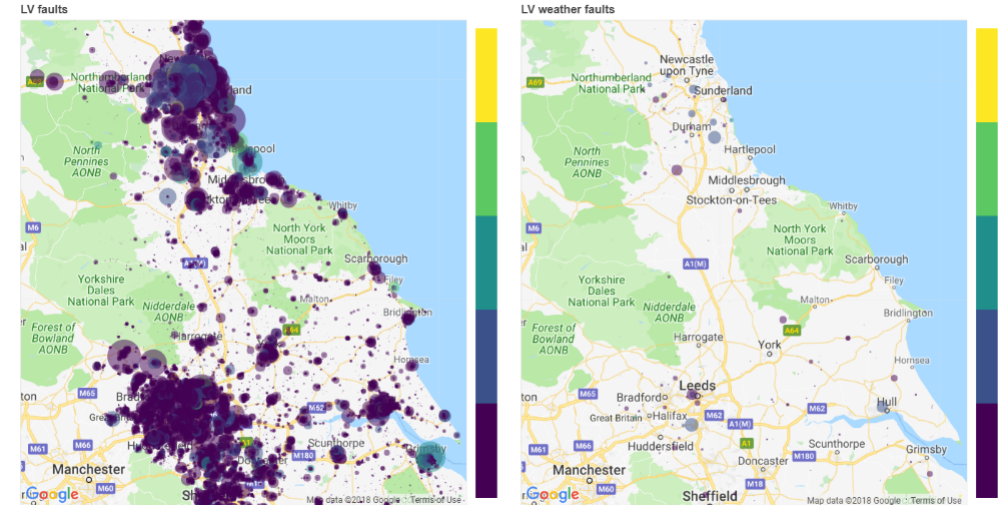
Figure 4. LV faults in NPG distribution network licence area–darker colour of circles indicates lower CML ( left : all faults, right : weather related faults).